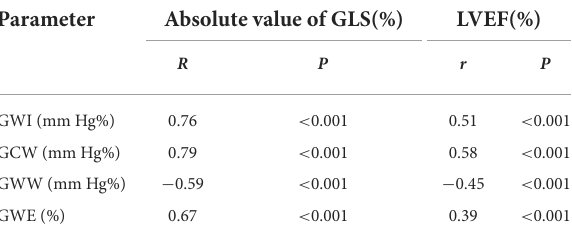
TABLE 5 Relationship between myocardial work parameters and